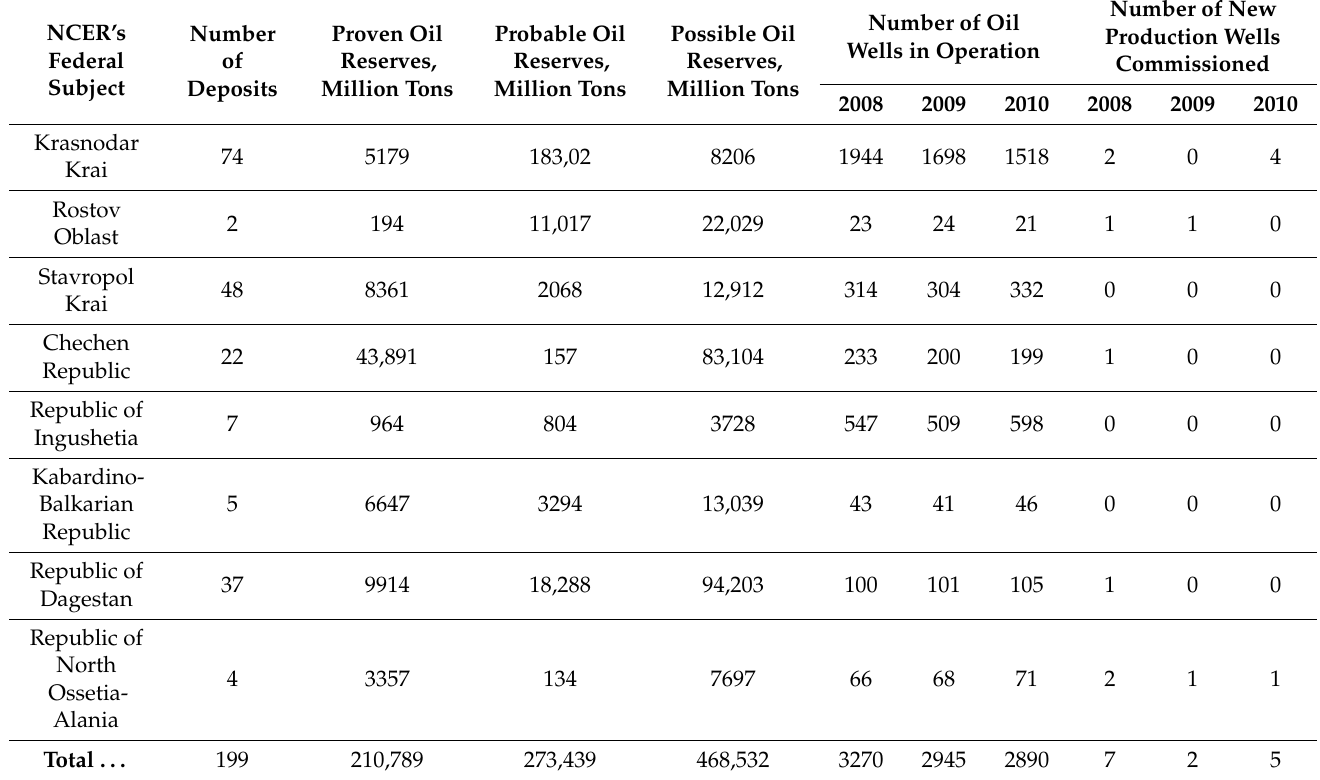
Table 1. Reserves and operating wells in the subjects of the North Caucasus Economic Region (NCER) * in 2008–2010 [34] (Own translation).